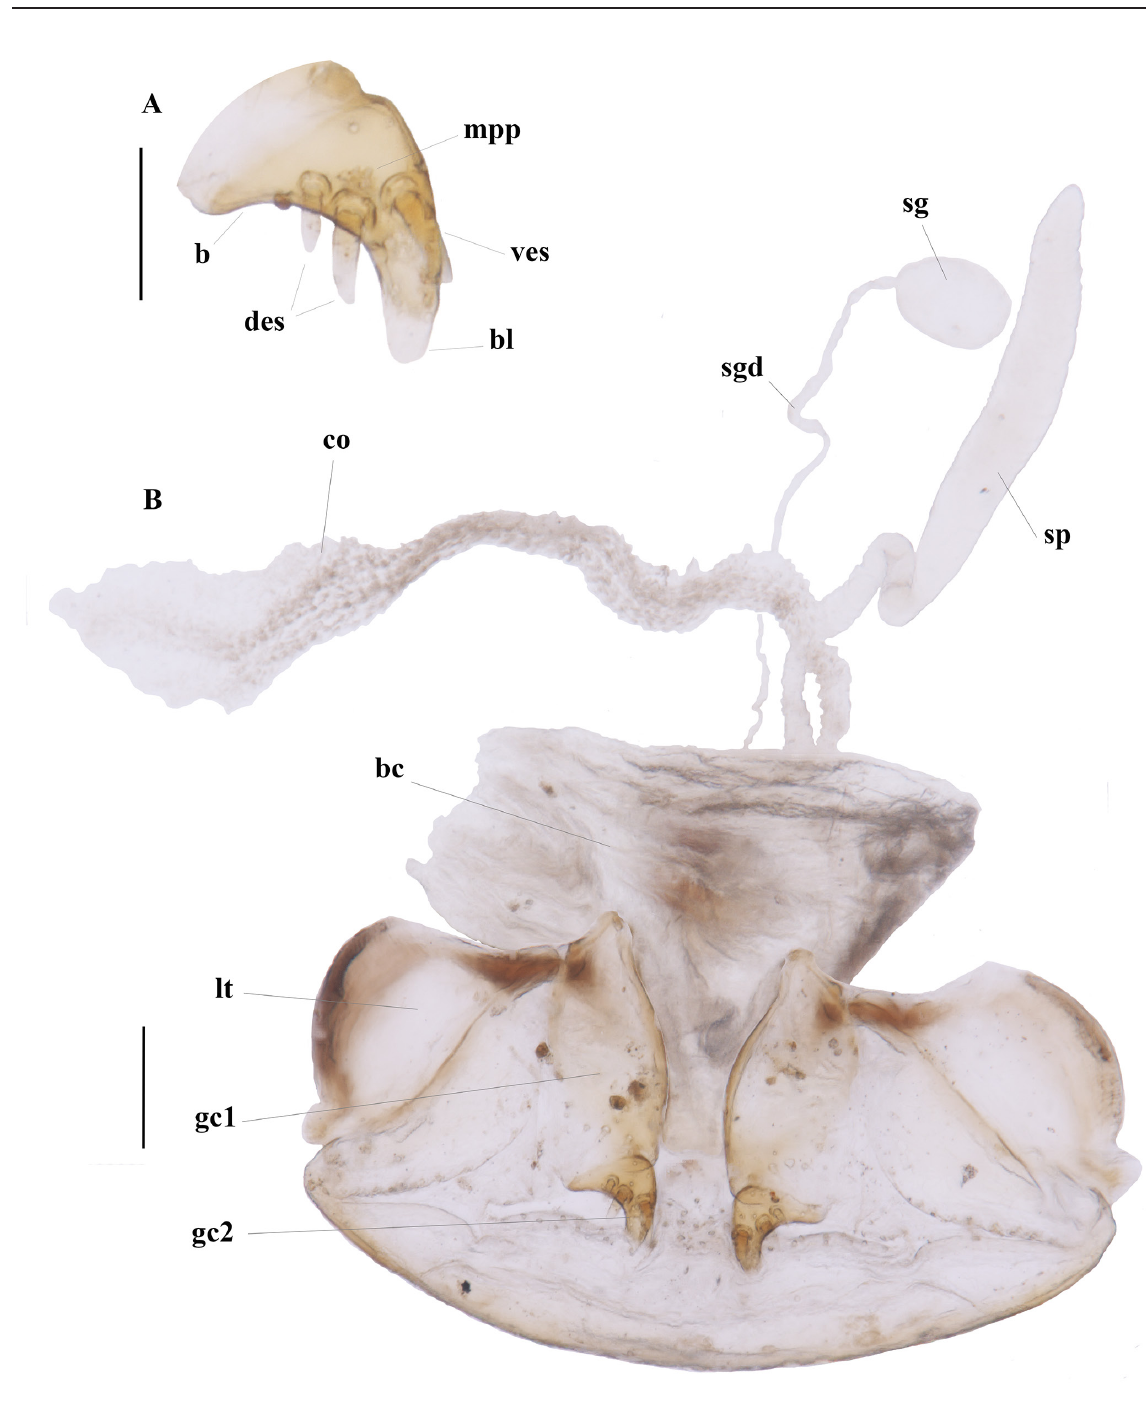
Fig. 4. Female genitalia, Perigona ( Neoperigona ) spelunca sp. nov., paratype (ISLA 363). A . Gonocoxite 2, dorsal aspect. B . Female reproductive tract in dorsal aspect. Abbreviations: b = base of gonocoxite 2; bc = bursa copulatrix; bl = blade of gonocoxite 2; co = common oviduct; des = dorsal ensiform seta; gc1 = gonocoxite 1; gc2 = gonocoxite 2; lt = laterotergite; sg = spermathecal gland; sgd = spermathecal gland duct; sp = spermatheca; ves = ventral ensiform setae; mpp = marginal pit pegs Scale bars: A = 0.05 mm; B = 0.1